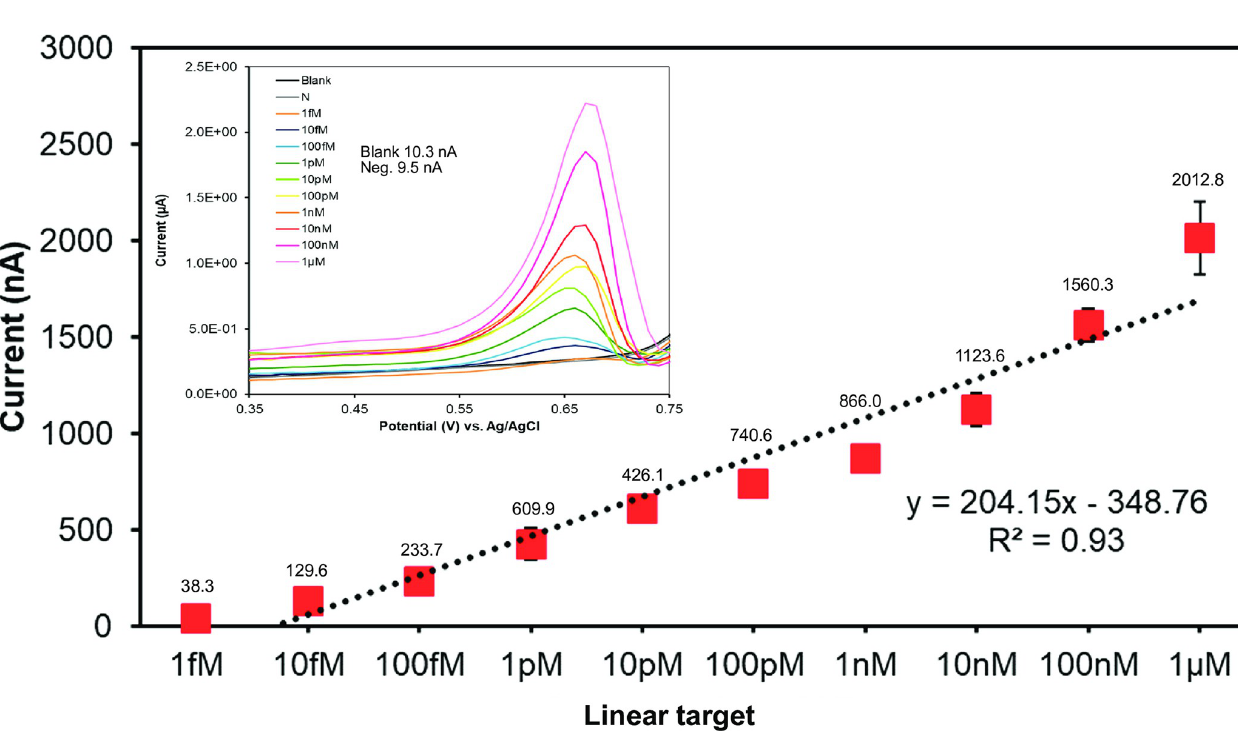
Fig 4. Calibration curve of synthetic w AlbB linear target strand displacement platform using electrochemical